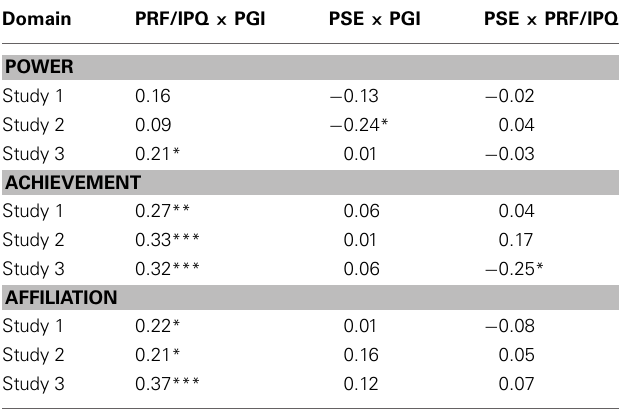
Table 3 | Within-domain correlations between personal goal commitments (PGI), self-attributed motives (PRF/IPQ), and implicit motives (PSE) for studies 1 and 2 (US samples) and 3 (German